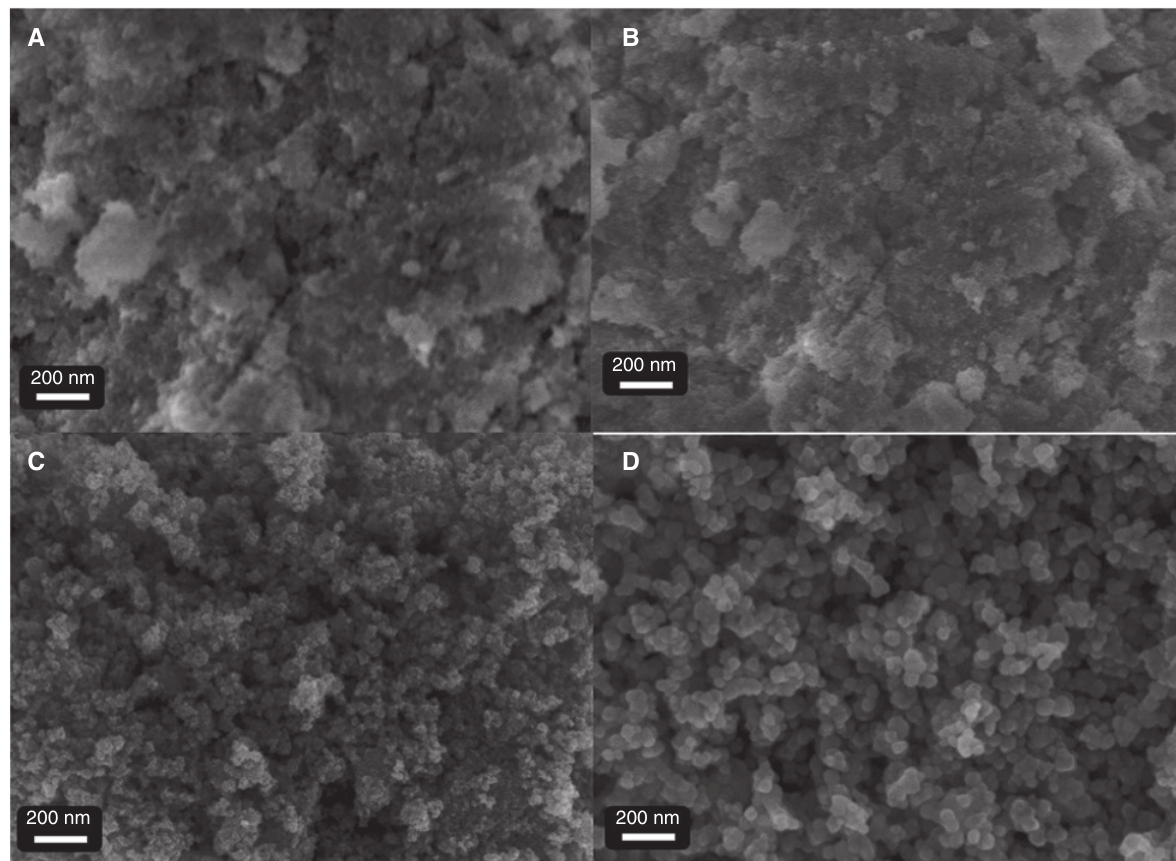
Figure 1: The field emission scanning electron microscopy (FESEM) images of the antimony-doped tin oxide (ATO) nanoparticles (NPs) (Sn/Sn + Sb = 3% at.) obtained with calcination temperatures: (A) as-synthesized, (B) 500 ° C, (C) 800 ° C, and (D) 1000 °